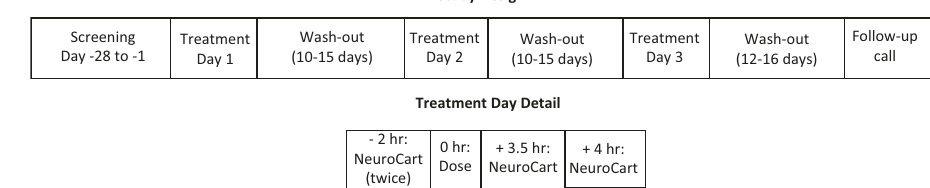
Fig. 1 Study design. Study design and the timing of NeuroCart assessments on treatment